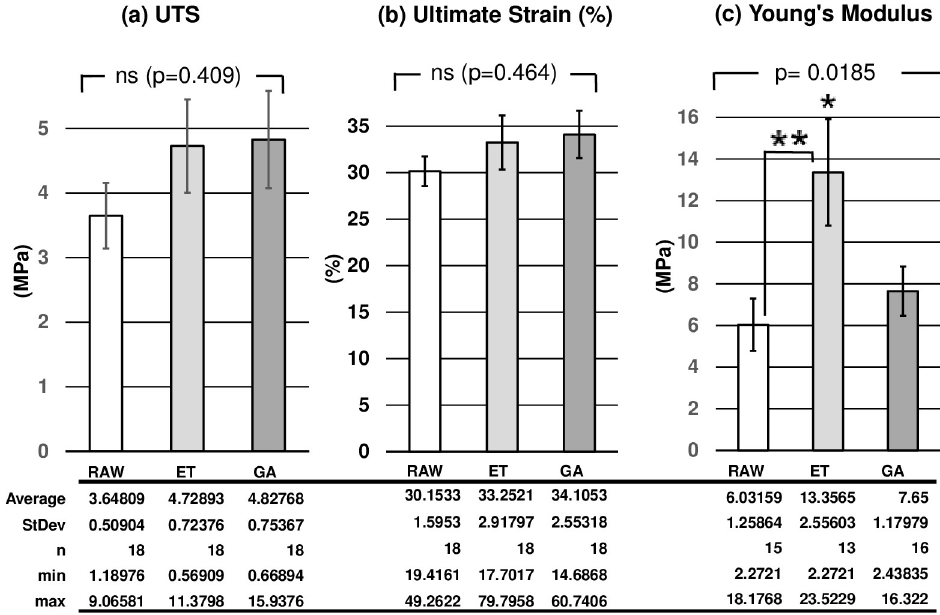
Fig 5. Results from the vessel ringlet pull test. Ultimate tensile strength (UTS) (a), ultimate strain (b), and Young’s modulus (c) of the three groups (RAW: RAW group, ET: ET group, GA: GA group, ns: no statistical differences. � Young’s modulus of ET group was significantly higher among the three groups, �� Young’s modulus of ET group was significantly higher than that of RAW group.